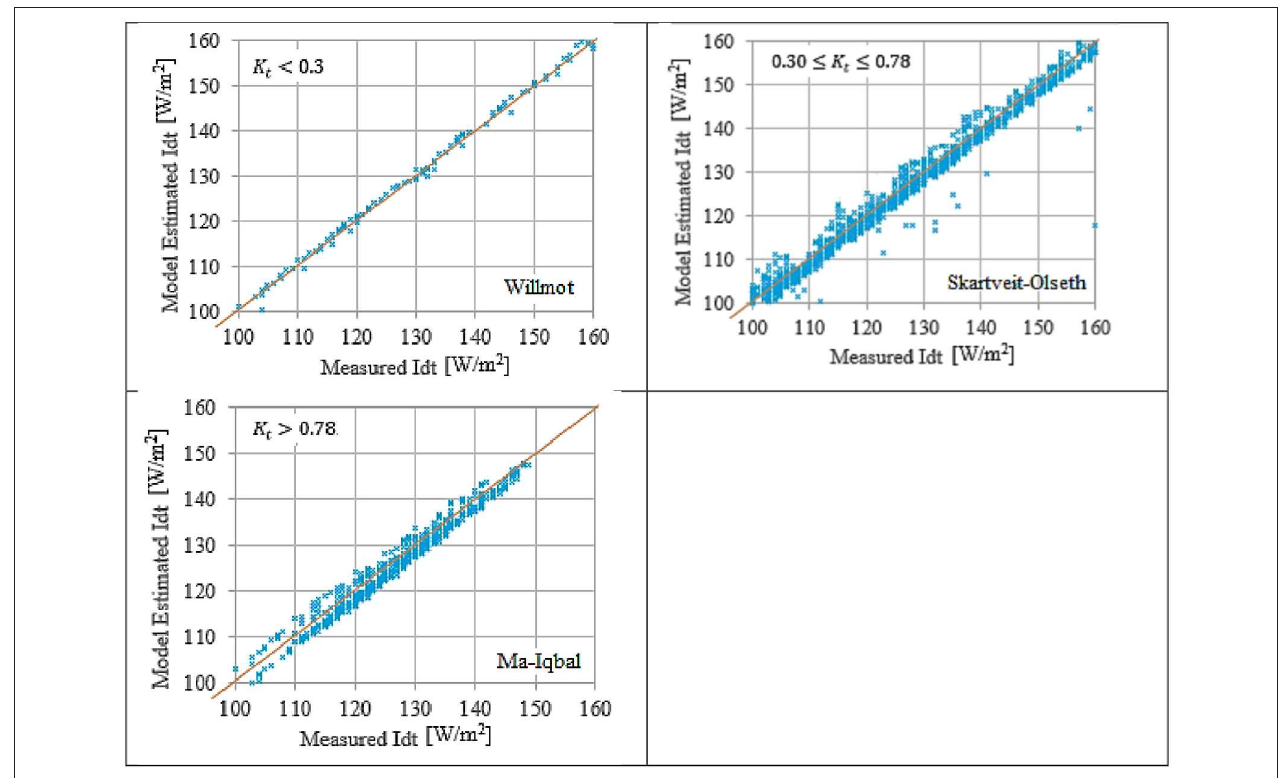
FIGURE 6 | Preferred transposition model for different sky conditions for Nablus city (8,700 points depicted in the graph) (blue dot), y = x relation (red line).